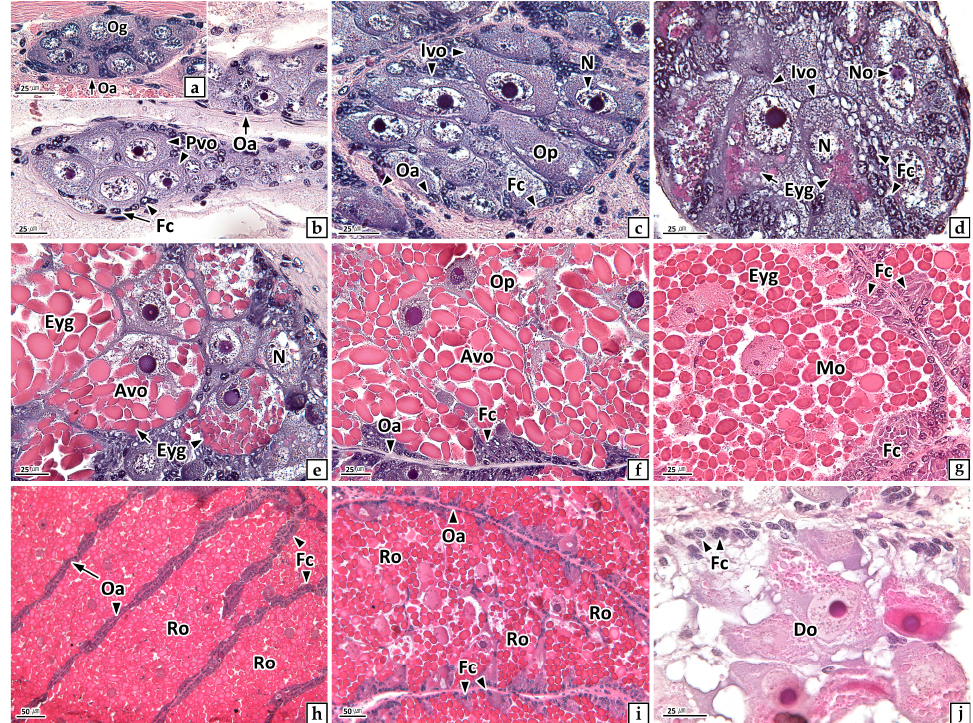
Figure 4. Ovarian development stage of Buccinum osagawai . H–E stain. ( a ) oogonia (Og) in inactive stage; ( b ) previtellogenic oocytes (Pvo) in inactive stage; ( c , d ) initial vitellogenic oocytes (Ivo) in early active stage; ( e , f ) active vitellogenic oocytes (Avo) in late active and mature stage; ( g ) mature oocytes (Mo) in late active and mature stage; ( h ) ripe stage; ( i ) ripe oocytes (Ro) in ripe stage; ( j ) spent and degenerative stage. Do: degenerative oocytes; Eyg: eosinophilic yolk granules; Fc: follicle cells; N: nucleus; No: nucleolus; Oa: oogenic acinus; Op: